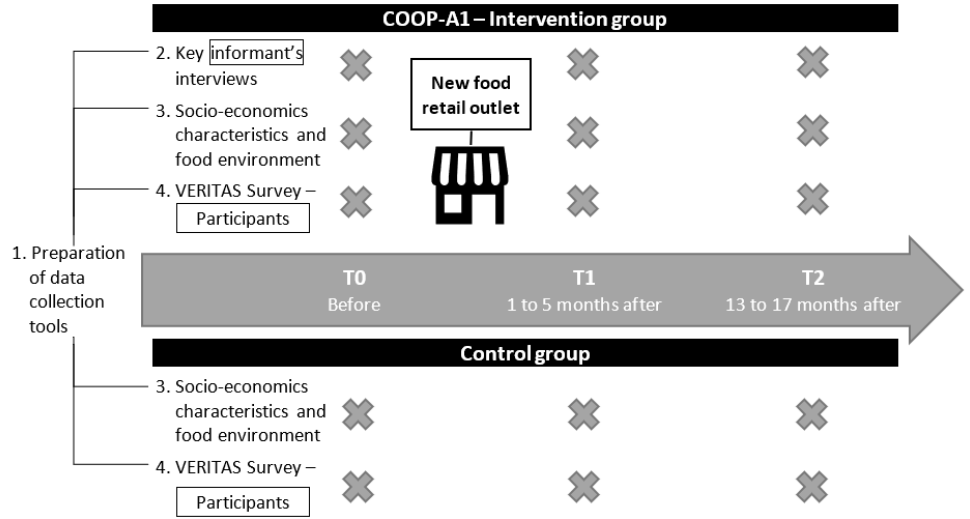
Figure 2. Research activities schema.